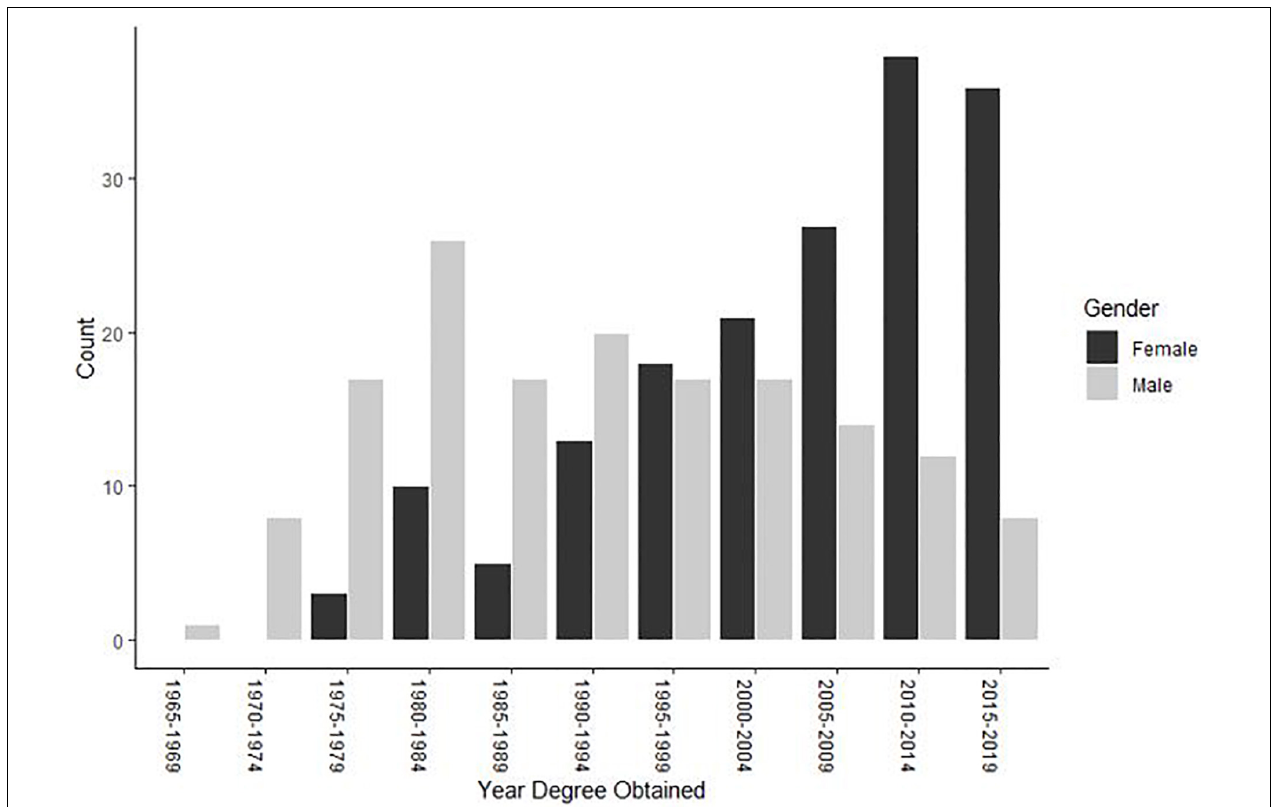
FIGURE 4 | Year terminal degree received by raw count within